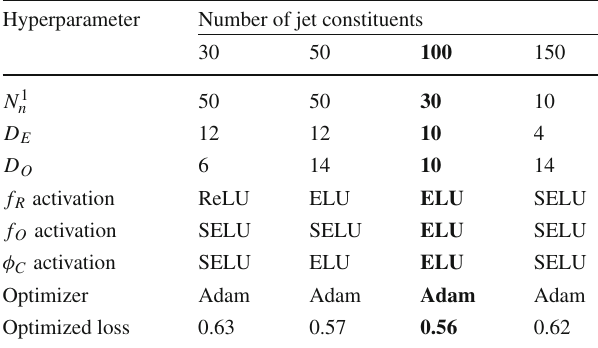
Table 2 Optimal JEDI-net hyperparameter setting for different input datasets,whenallthe O ij elementsaregivenasinputtothe φ C network. The best result, obtained when considering up to 100 particles per jet, is highlighted in bold